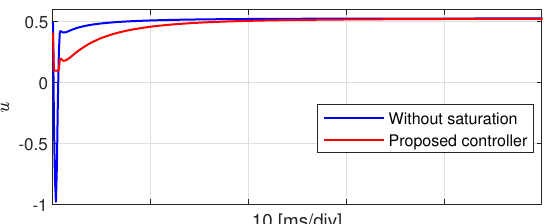
Figure 4. The zooms of the controller inputs with the saturation and without it.